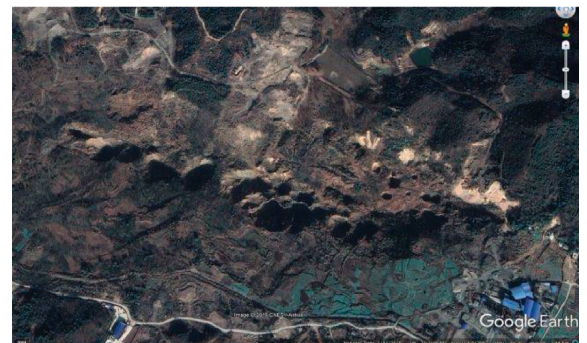
Figure 2: Subsidence features at China’s Chengchao iron ore mine. Image courtesy of Google Earth, taken in 2018.